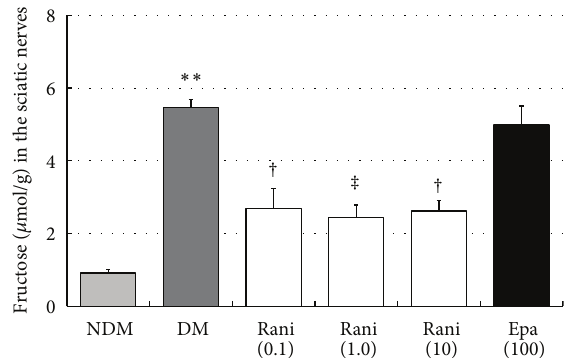
Figure 12: The sorbitol levels in the sciatic nerves at 40 weeks. The sorbitol level in the sciatic nerves in the untreated SDT rats is significantly higher that of the SD rats. ∗∗ 𝑃 < 0.01 , Student’s 𝑡 - test. The sorbitol levels in the sciatic nerves treated with all doses of ranirestat (10.0 and 1.0mg/kg/day) are lower than in the untreated SDT rats. † 𝑃 < 0.05 and ‡ 𝑃 < 0.01 , Dunnett type joint-ranking test. Epalrestat does not affect the reduction in the sorbitol level. NDM: non-diabetes mellitus; DM: diabetes mellitus; rani: ranirestat; epal: epalrestat.